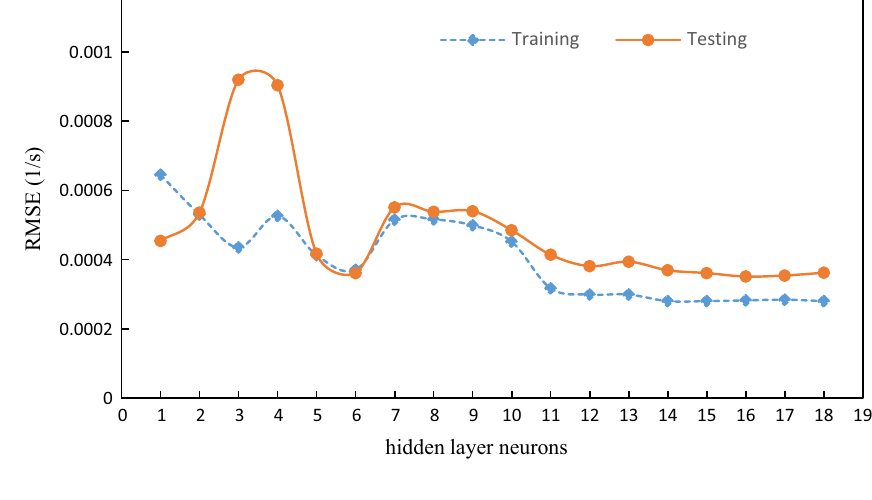
Fig. 8 Variation of coefficient of determination ( R 2 ) and RMSE with hidden layer neu- rons during training and testing